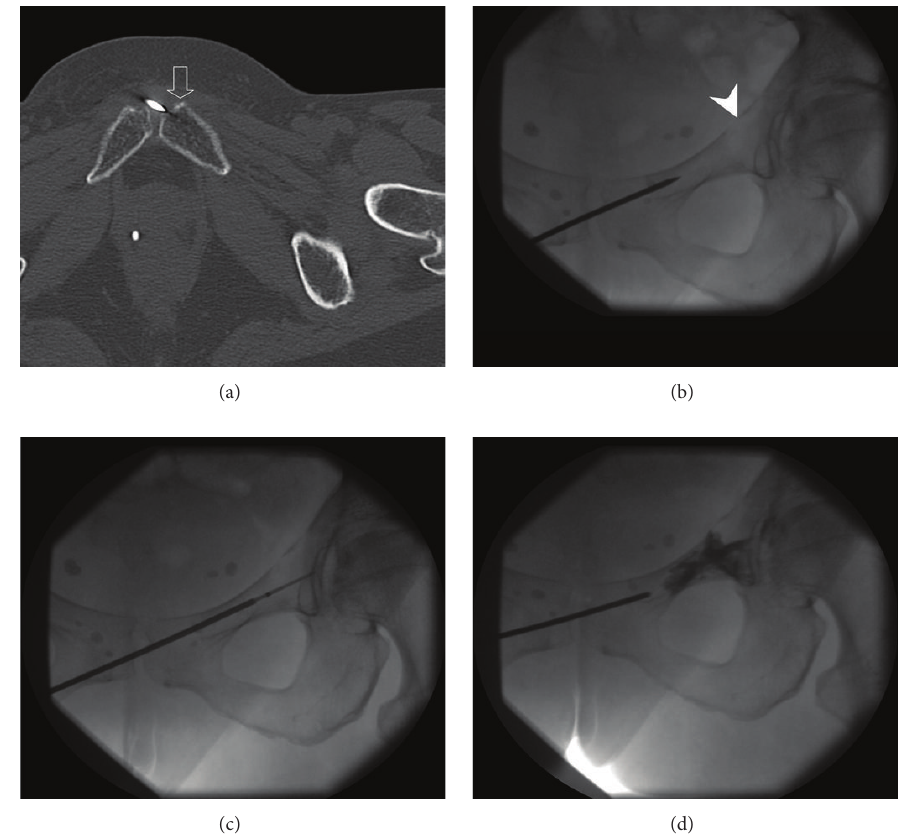
Figure 2: (a) Nonenhanced axial CT image demonstrates the entry point of the retrograde transpubic approach via the pubic tubercle (open arrow). (b)–(d) Anteroposterior fluoroscopic images show the needle guided through the superior pubic ramus toward the lesion